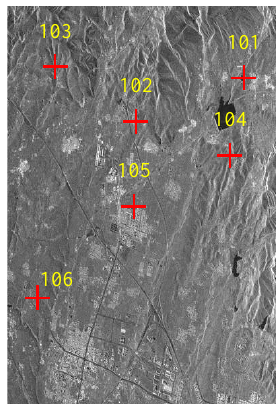
Figure 13. Distribution of corner reflector control points on Gaofen-3 SAR image. Table 4. Elevation accuracy evaluated by six GCPs.